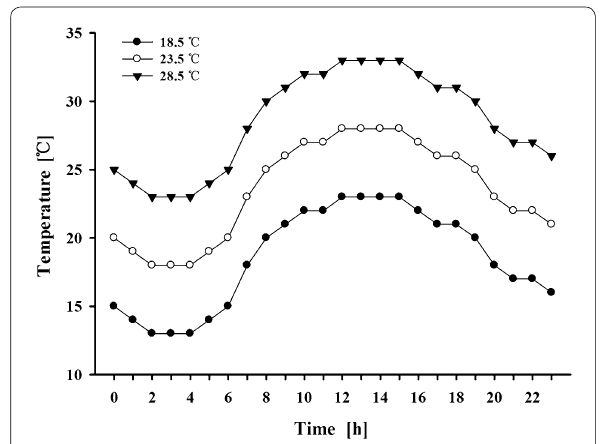
Fig. 1 Different growth temperature settings in